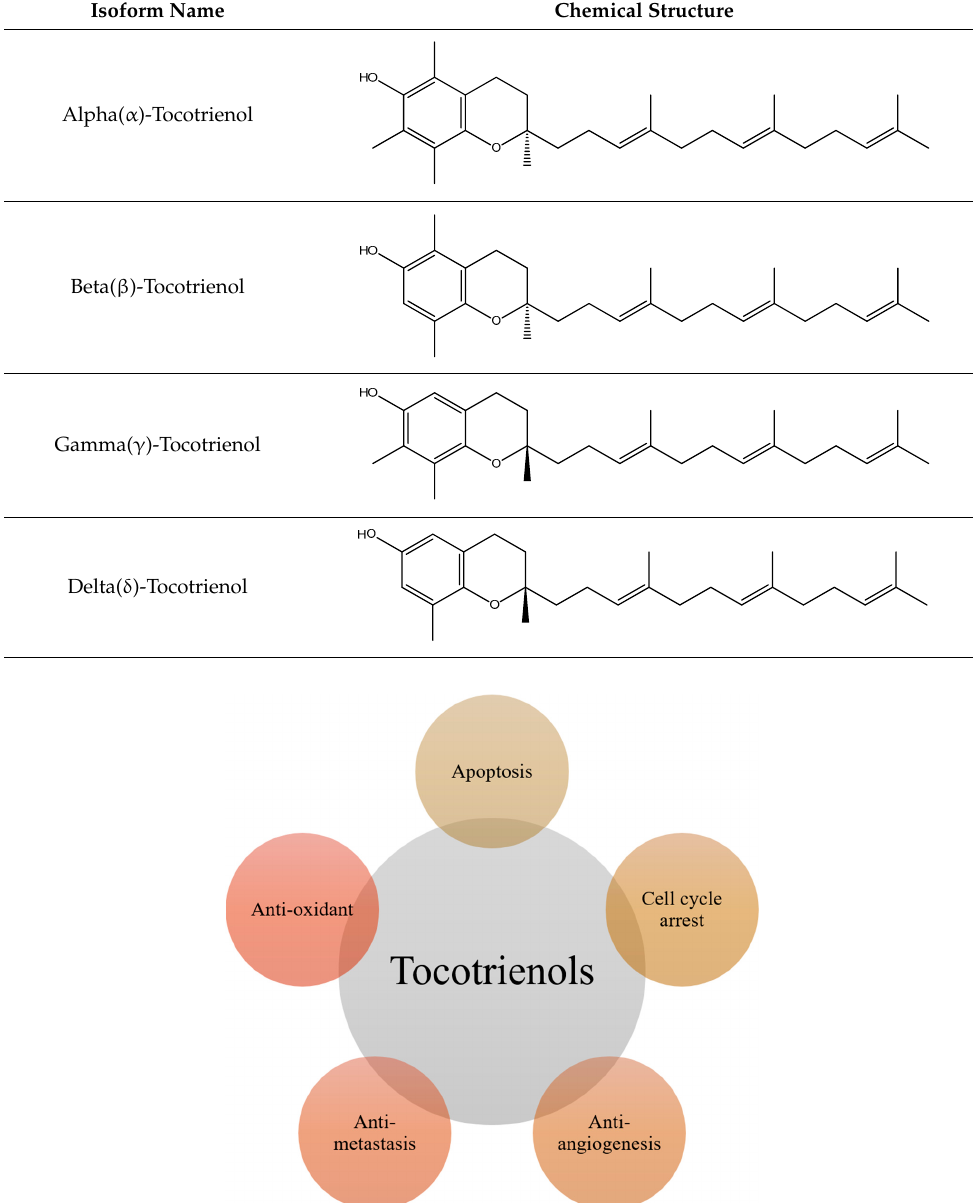
Table 1. Chemical structures of different isoforms of tocotrienols.